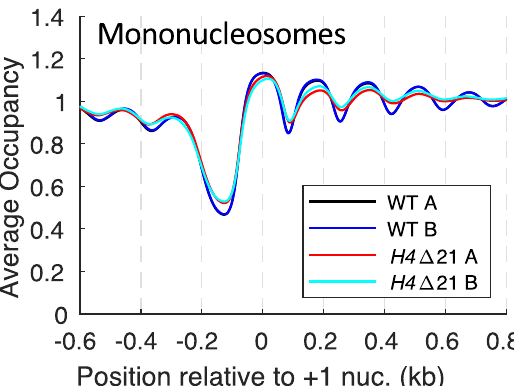
Figure 5. Deletion of the first 21 residues of the H4 N-terminal tail domain results in shorter global nucleosome spacing but little dinucleosome accumulation. (a) Comparison of the H4ΔN21 mutant with its isogenic wild type strain (WT-H4) (top panel). WT-H4 replicates (bottom panel). All yeast genes were aligned on the midpoints of their + 1 nucleosomes. The dyad distribution was normalised to the global average (set at 1). WT-H4 replicate A: black line with grey fill in both plots. The average spacing in bp is shown for each replicate in the bottom right corner. ( b) Occupancy plots for dinucleosomes and mononucleosomes in H4Δ21 and wild type (WT) cells (see legend to Fig.